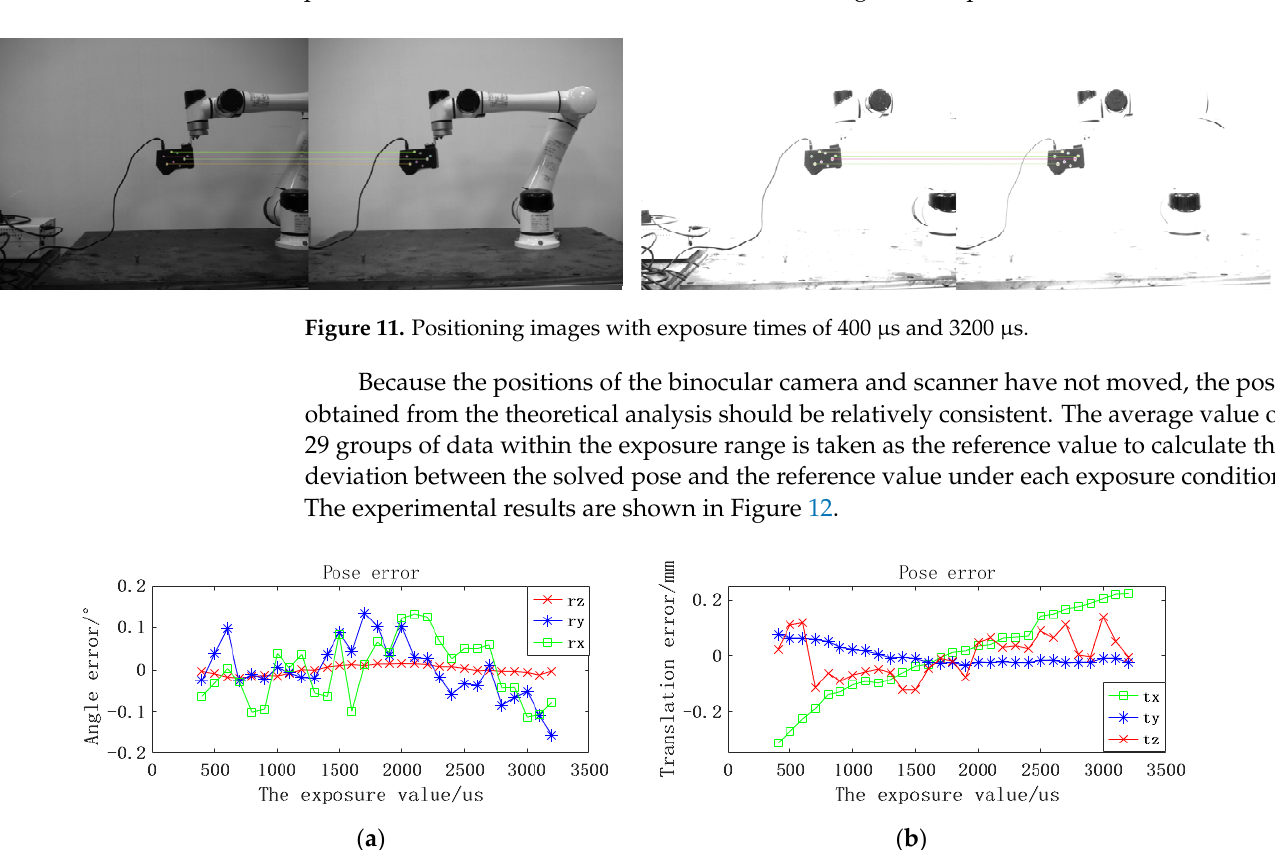
Table 4. Comparison of the distance measured result with the actual value.